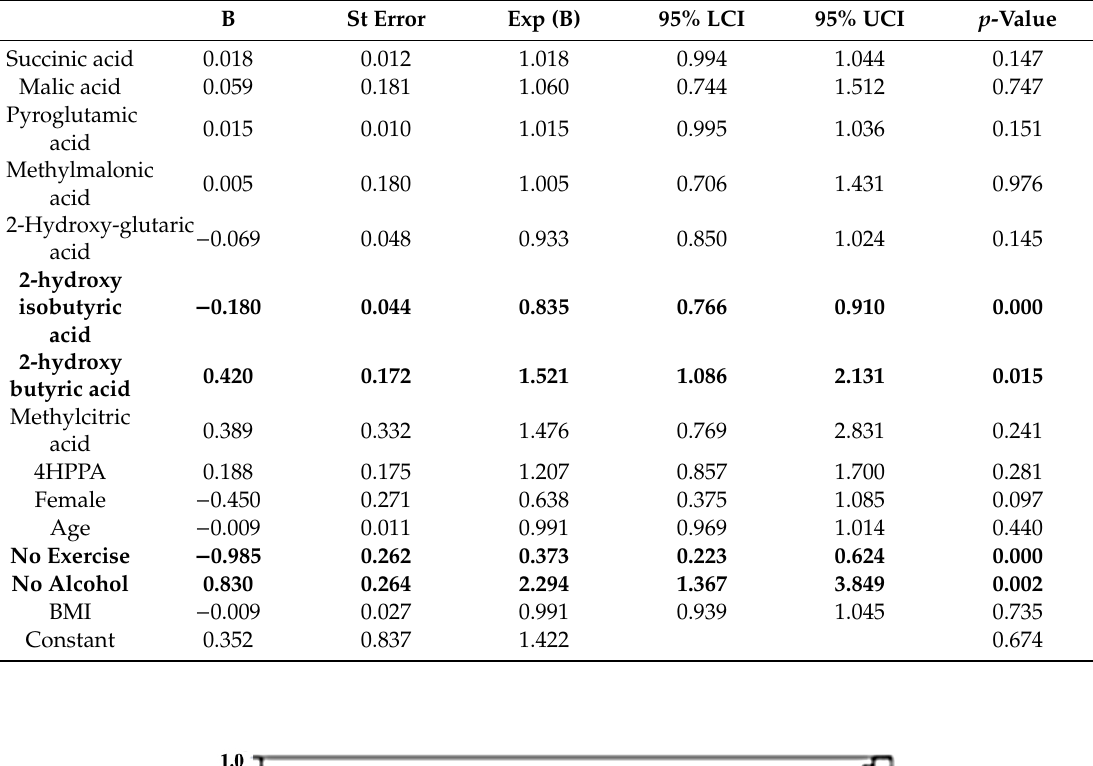
Table 2. Association of the presence of autoimmune disease with patient’s characteristics and organic acids levels; Dependent Variable: Absence of autoimmune disorder; Binary Logistic Regression Model; p < 0.05 are shown in bold. 4-HPPA: 4-Hydroxyphenypyruvic acid LCI: Lower Confidence Interval; UCI: Upper Confidence Interval.